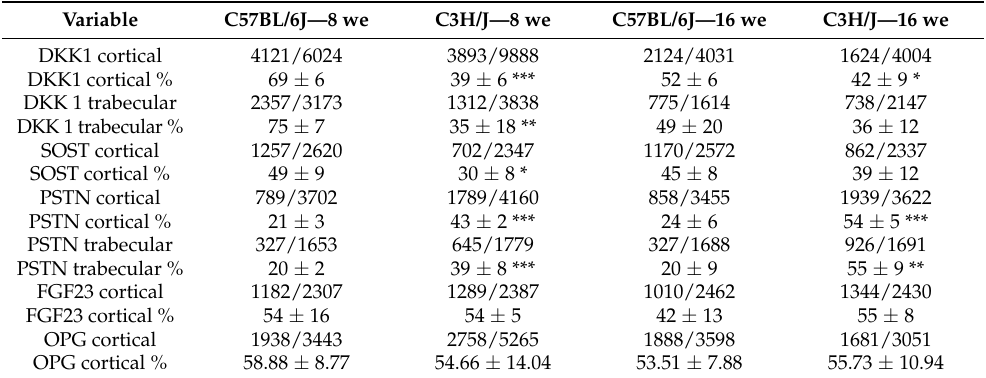
Table 1. Immunohistochemistry: Osteocytes positive for different proteins as absolute values of the total number of counted osteocytes and as